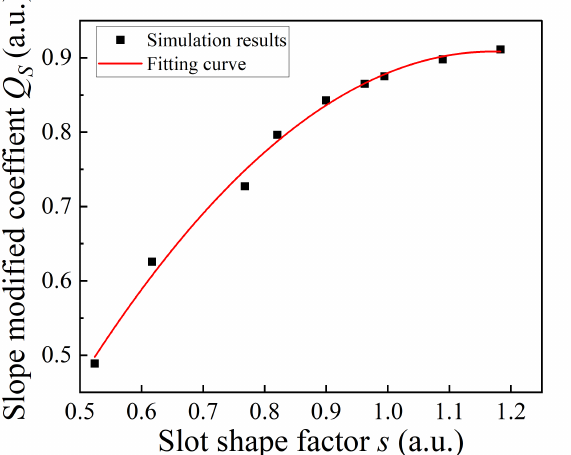
Figure 4. Slope-modified coefficient versus slot shape